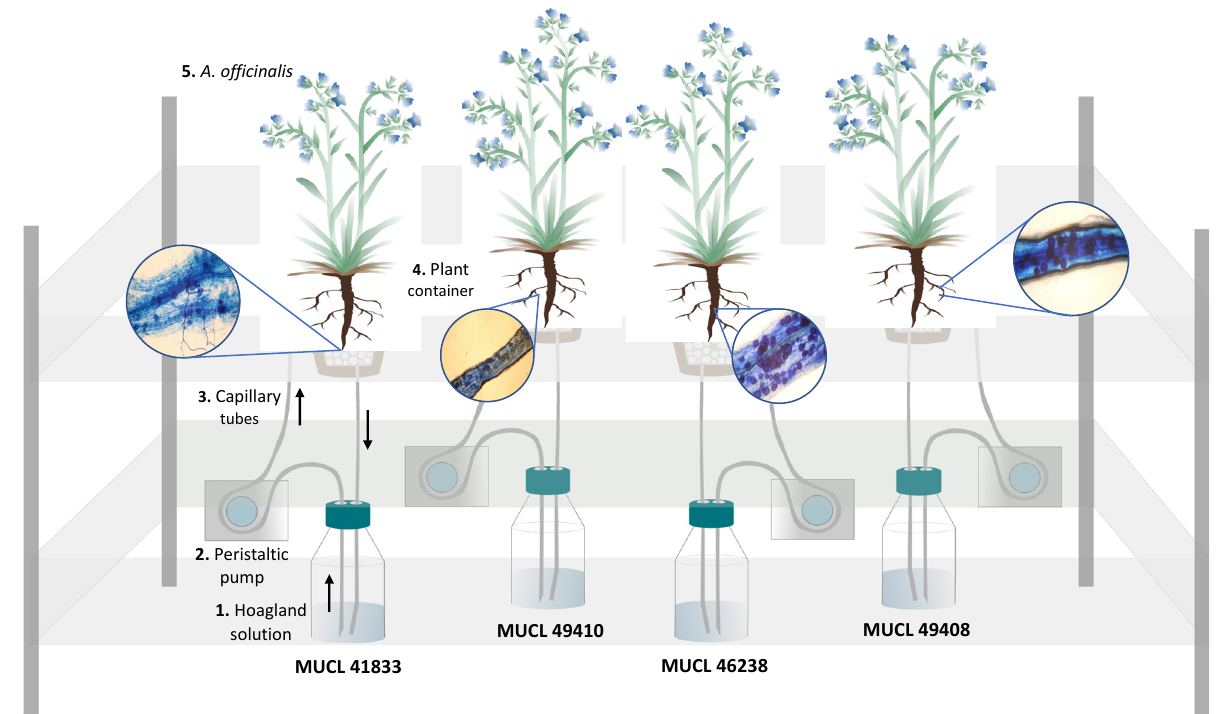
Figure 6. Schematic representation of the circulatory semi-hydroponic cultivation system. The Hoagland solution circulated through the containers supporting Anchusa officinalis plants associated with four different AMF species ( R. irregularis MUCL 41833; R. intraradices MUCL 49410; R. clarus MUCL 46238; R. aggregatus MUCL 49408). The nutrient solution in the glass bottle (1) is pumped using a peristaltic pump (2) via silicon tubes (3) to the upper part of the plant container (4) containing A. officinalis plants (5). The solution percolates through the plant container back into the glass bottle. The black arrows indicate the flow direction of the nutrient solution in the tubing. The roots-stained images represent the plant-AMF colonization of the four different AMF species applied in this study.